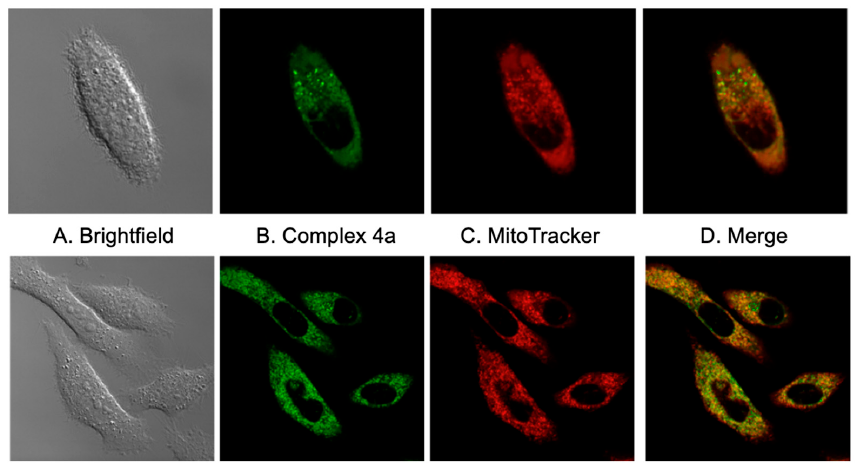
Figure 9. Determination of mitochondrial subcellular localization of complex 4a by confocal microscopy. PC-3 cells were incubated with complex 4a (500 nM) for 24 h and then co-incubated with MitoTracker Deep Red (200 nM) for 10 min at 37 °C. Iridium complex 4a was excited at 720 nm (two-photon) and emission was collected at 440–544 nm. MitoTracker was excited at 633 nm and the emission was collected at 644–700 nm. The full image for zoom 4 ( up ) was 53.14 μ m × 53.14 μ m and 106.27 μ m × 106.27 μ m for zoom 2 ( down ).